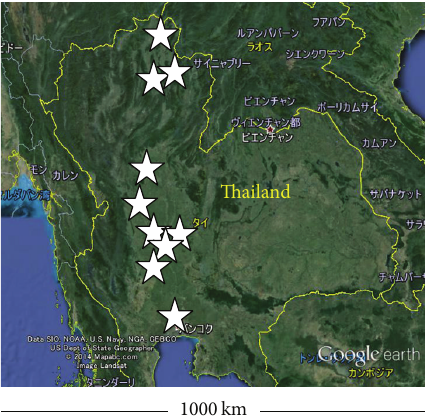
Figure1:Thesitesatwhichthesurveysinthisstudywereconducted. White stars indicate the approximate